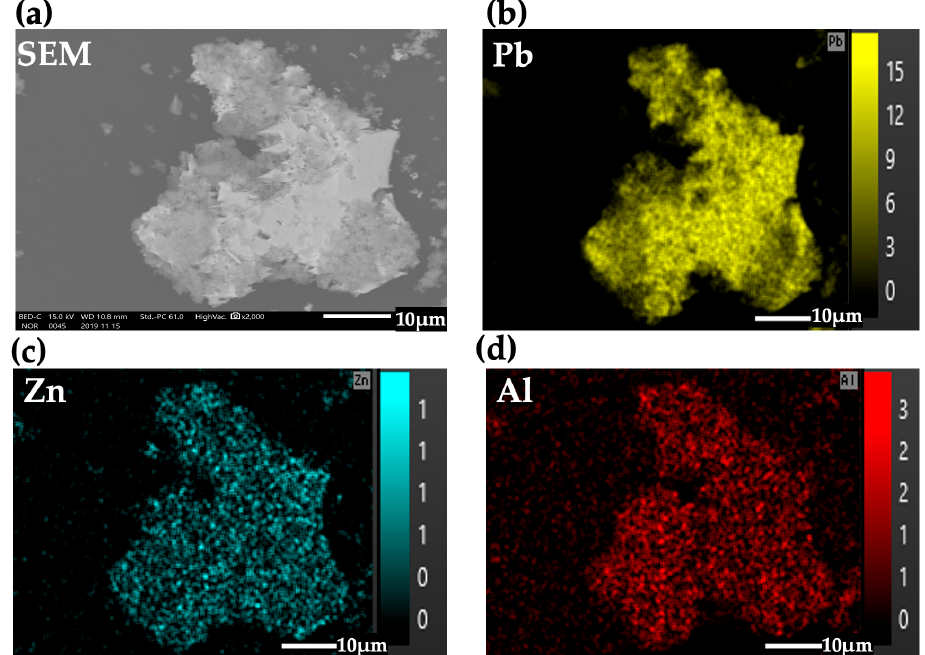
Figure 6. SEM-EDX of cementation product when 2.5 g ZPLRs were leached in 3 M NaOH solution for 30 min with the addition of 0.25 g Al powder: ( a ) SEM microphotography, ( b ) EDX map of Pb, ( c ) EDX map of Zn, and ( d ) EDX map of Al (for interpretation of the references to color in this figure legend, the reader is referred to the web version of this